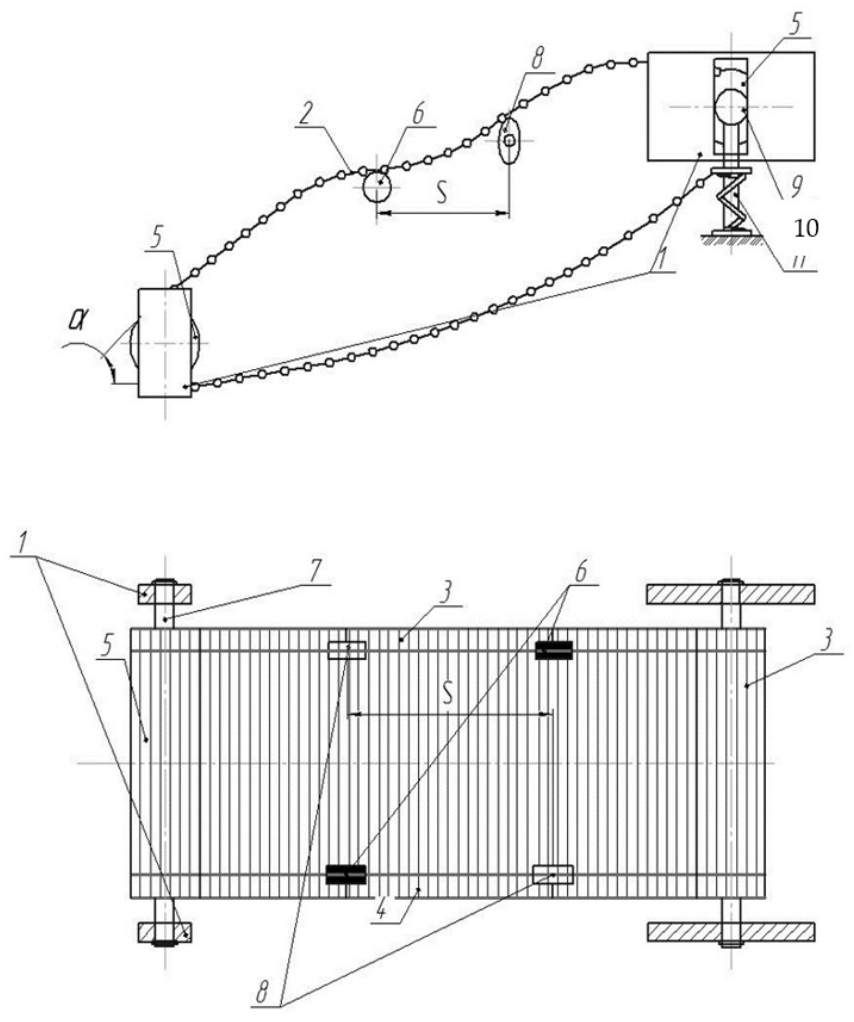
Figure 4. Scheme of separating rod elevator: 1—frame; 2—rod elevator; 3, 4—branches of rod elevator; 5—leading roller; 6—support roller; 7—driven roller; 8—elliptical shaker; 9—driven roller shaft; and 10—the mechanism for regulating vertical